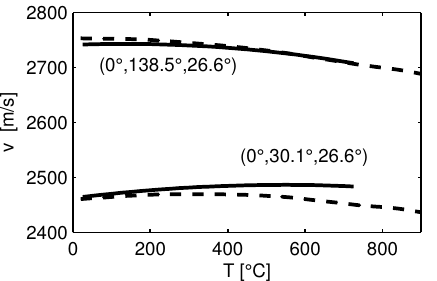
Figure 14. Comparison of Rayleigh wave velocity on free surface v 0 obtained from SAW and BAW measurements (solid and dashed lines,